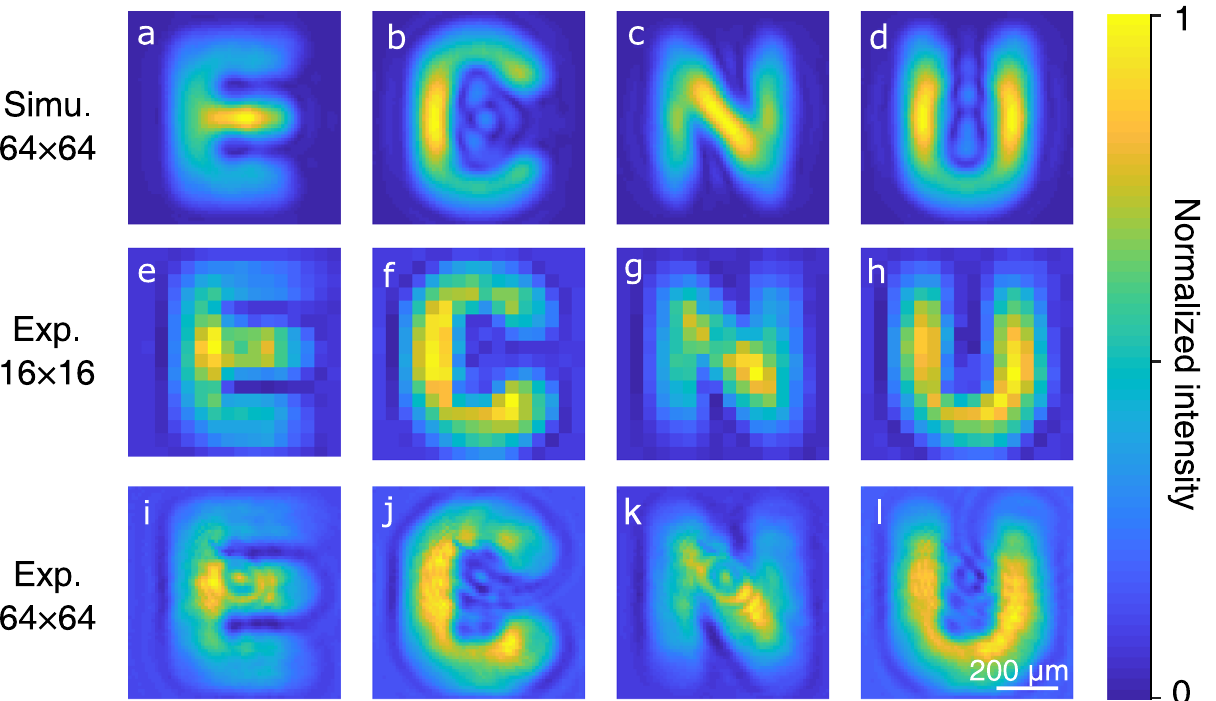
Fig. 3 | MIR single-pixel imaging based on Hadamard encoding. a – d Numerical simulations on the single-pixel upconversion imaging for the transmission object with four letters as shown at the bottom-left corner in Fig. 1. e – l Experimentally reconstructedobjectimageswithresolvablepixelsof16×16( e – h )and64×64( i – l ). The use of Hadamard patterns as the decomposition basis favors implementing